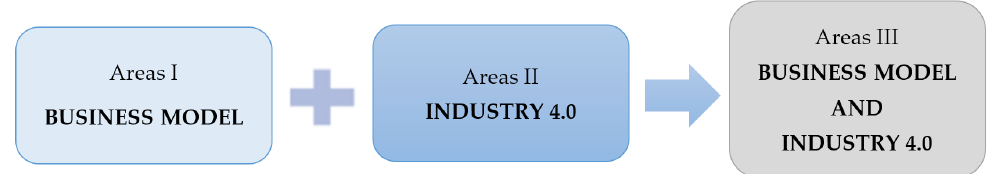
Figure 2. Areas of bibliometric analysis. Source: own elaboration.